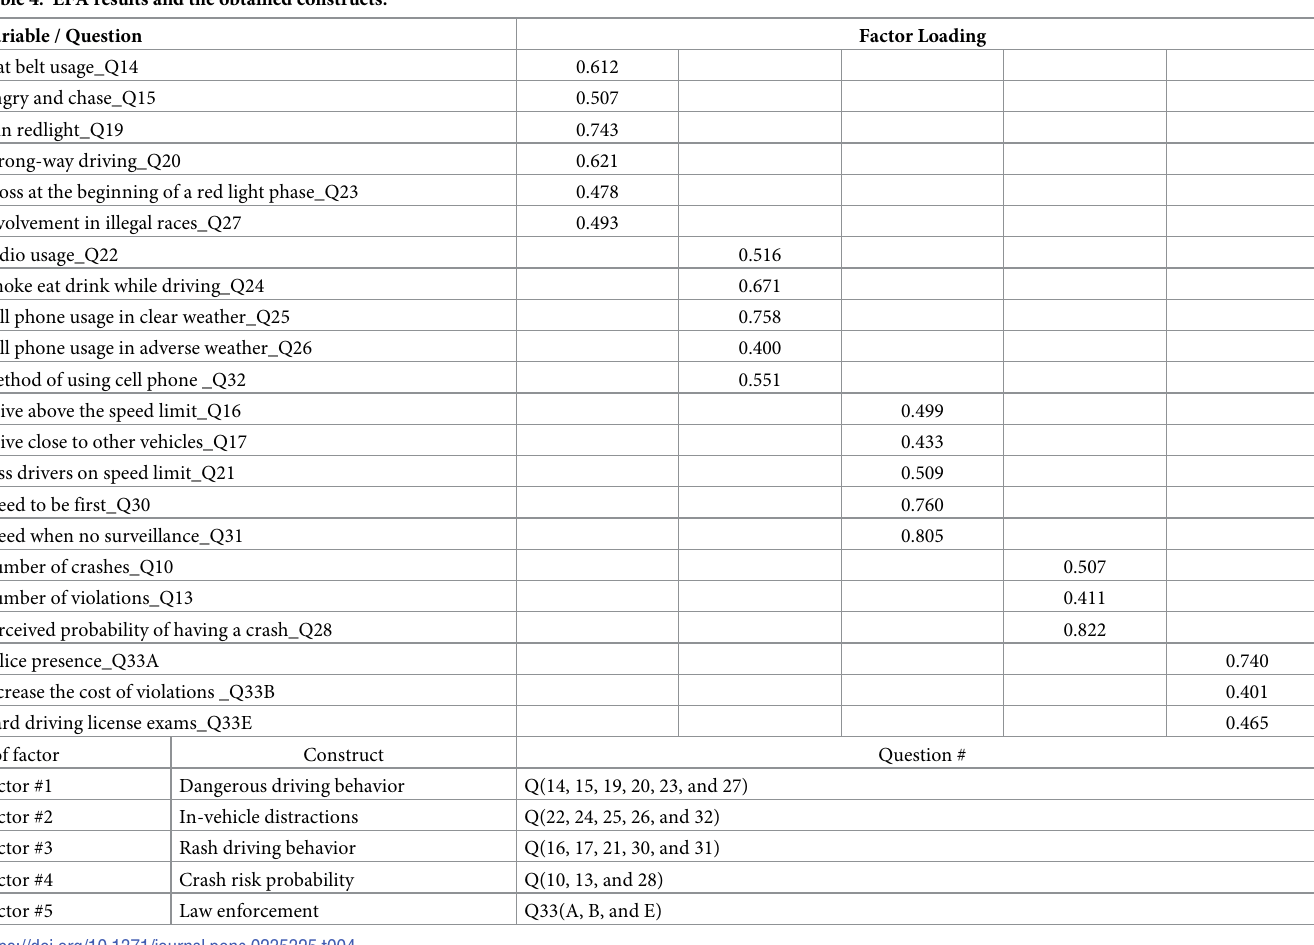
Table 4. EFA results and the obtained